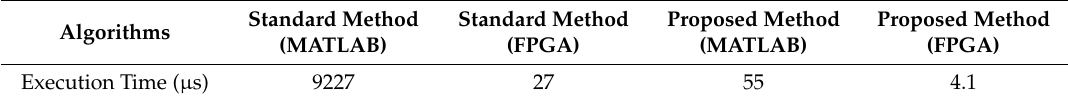
Table 1. Running time of di ff erent methods and platforms.